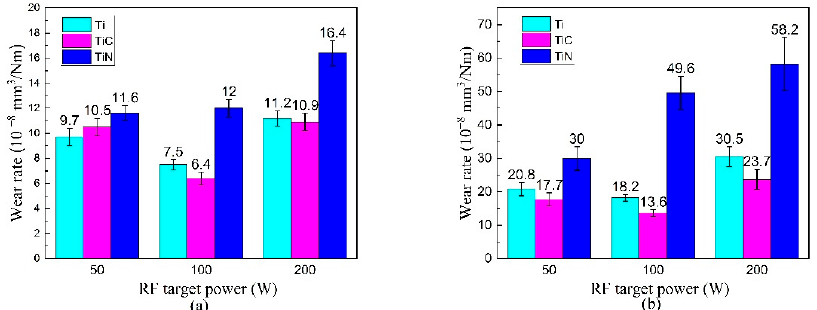
Figure 14. Wear rate of (Ti:N)-GLC films: ( a ) Mixed lubrication; ( b ) Boundary lubrication.